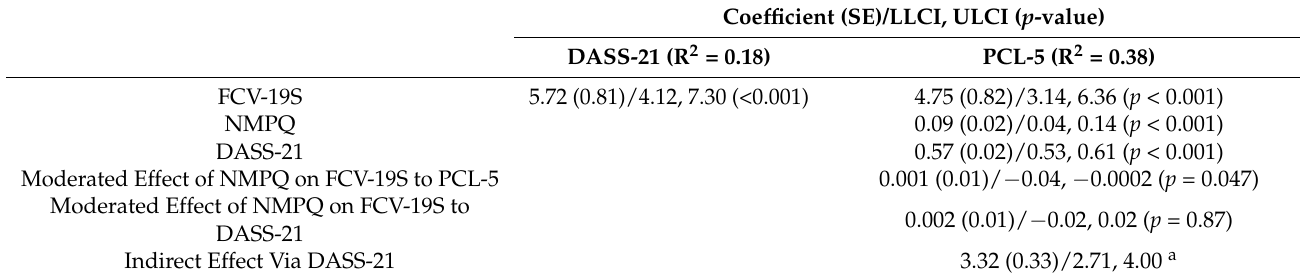
Table 3. Results of Hayes’ PROCESS Model